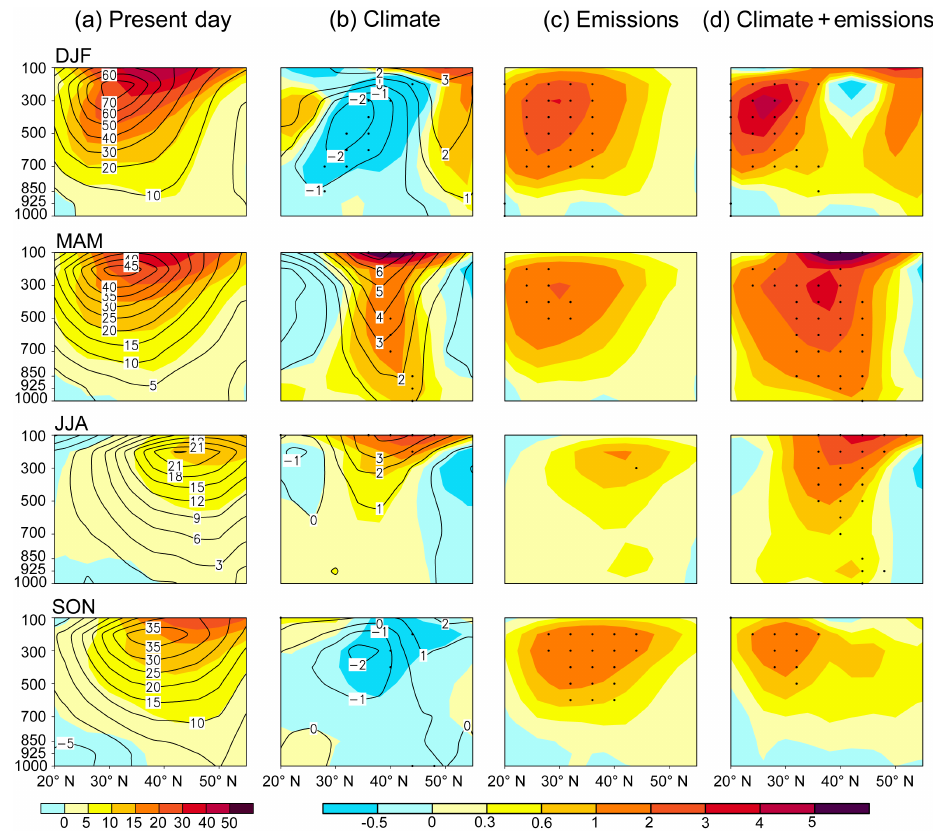
Figure 10. (a) The pressure–latitude cross sections along 135 ◦ E of the simulated present-day O 3 mass fluxes and zonal winds (Met2000Emis2000). The projected changes in O 3 mass fluxes and zonal winds from the present day (1996–2005) to the future (2046– 2055) caused by (b) climate change alone (Met2050Emis2000 minus Met2000Emis2000), (c) changes in anthropogenic emissions alone (Met2000Emis2050 minus Met2000Emis2000), and (d) changes in both climate and anthropogenic emissions (Met2050Emis2050 minus Met2000Emis2000). The O 3 mass fluxes are shown by the colored shading (kgseason − 1 m − 2 ) , and the winds are represented by the con- tours (ms − 1 ) . The dotted areas are statistically significant at the 95% level, as determined by a two-sample Student’s t